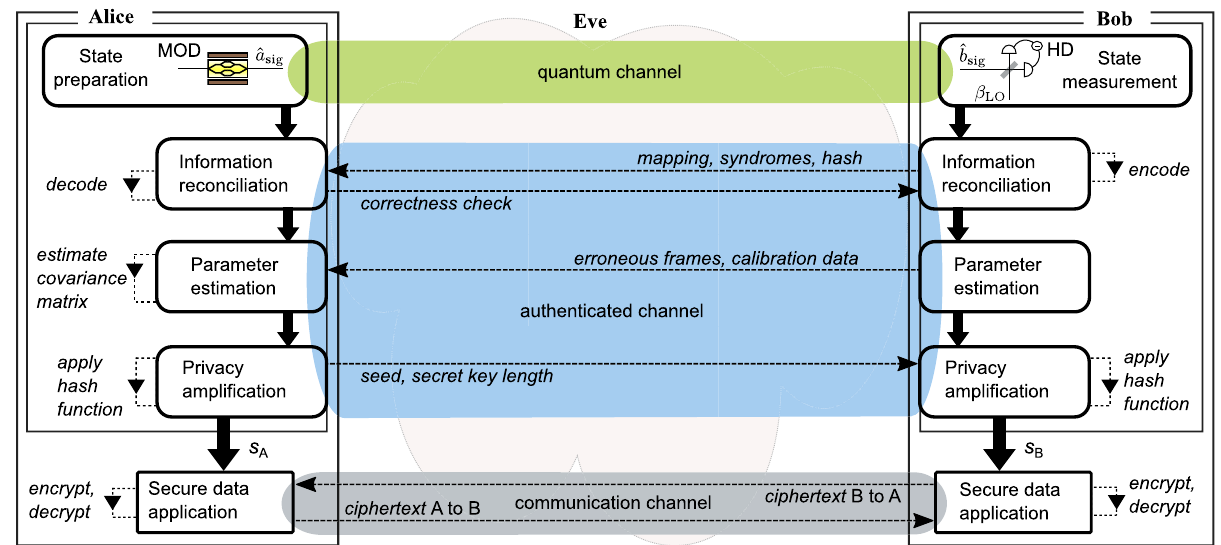
Fig. 1 | Composability in continuous-variable quantum key distribution (CVQKD) with coherent states. Alice and Bob obtain quantum correlations over the quantum channel by means of modulation (MOD) and local oscillator (LO) aidedhomodyne/heterodynedetection(HD)toprepareandmeasure,respectively, optical coherent states. After going through the remaining steps of the protocol thatinvolvetheauthenticatedchannel,theyobtaincorrelatedbitstreams s A and s B , respectively. Certain criteria associated with correctness, robustness, and secrecy of the protocol must be satis fi ed, for the application to assure composable